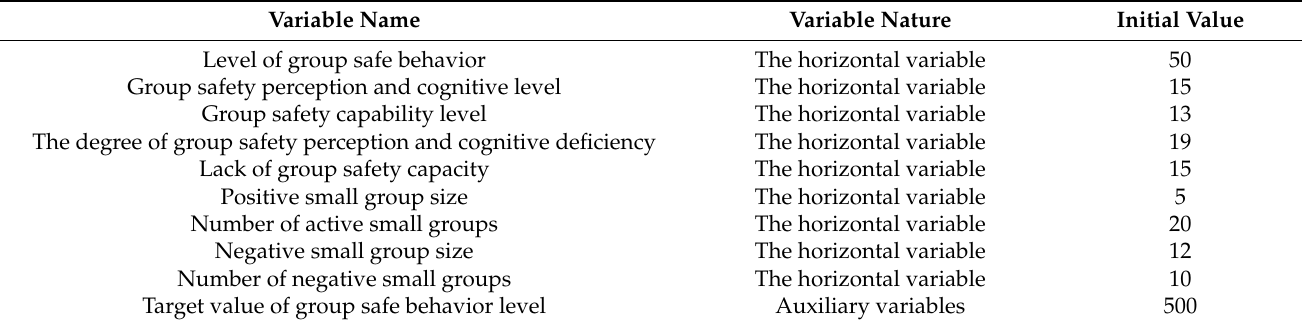
Table 1. Data table of initial values of some variables in SD model.